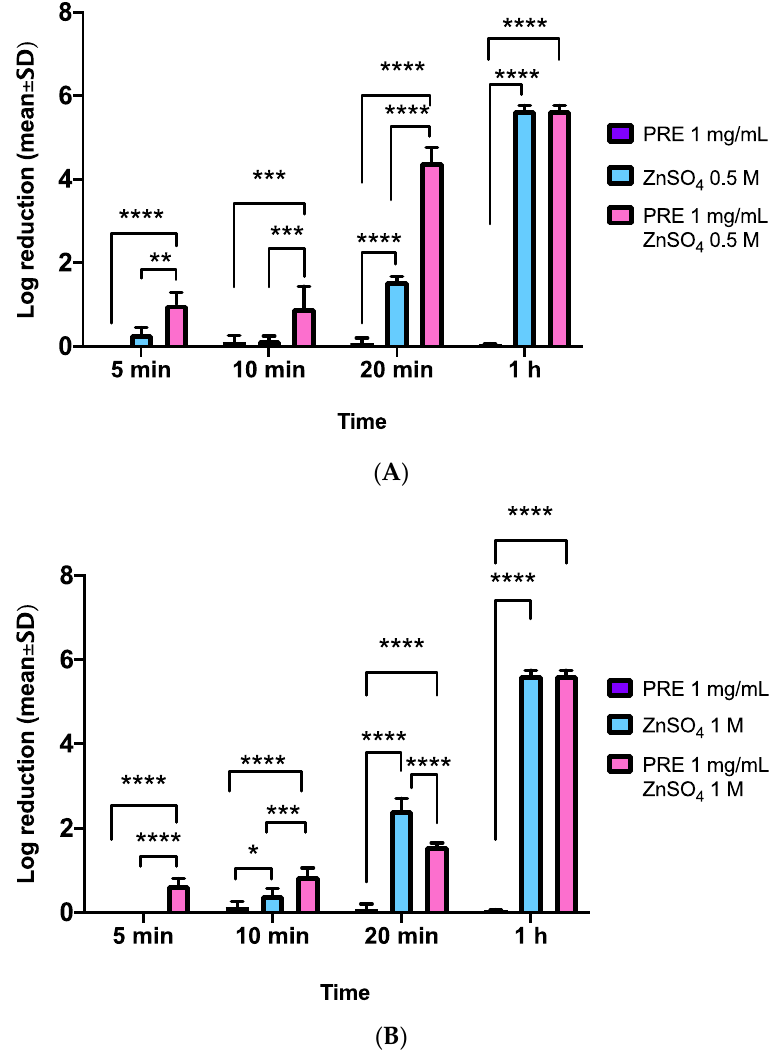
Figure 2. Log 10 reductions in MRSA CFUs at incubation times of 5 min, 10 min, 20 min, and 1 h ( n = 9 ± SD). ( A ) PRE (1 mg/mL), and Zn (II) (0.5 M) alone and in combination. ( B ) PRE (1 mg/mL), Zn (II) (1 M) alone, and in combination. Tukey’s multiple comparison post-hoc test show statistically significant differences (* p ≤ 0.05, ** p ≤ 0.01, *** p ≤ 0.001, **** p ≤ 0.0001).